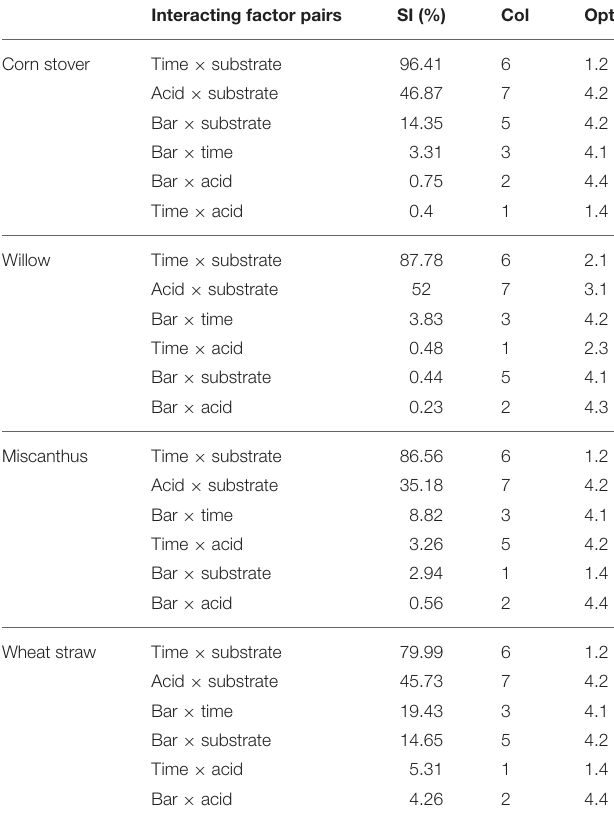
TABLE 6 | SE Taguchi DoE model set of parameters (A) and best performing conditions from L 16 experiment (B) for maximum xylose release from LCBs (WW, Willow; WS, Wheat straw; CS, Corn stover; MG, Miscanthus ×